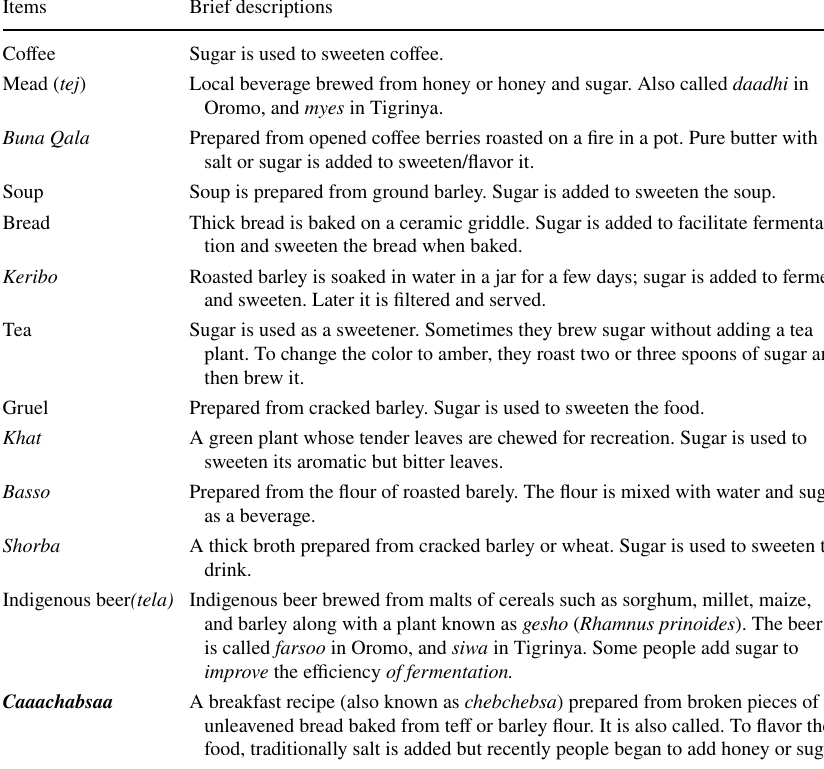
Table 1 Major foods, recipes, and beverages with which sugar is used in